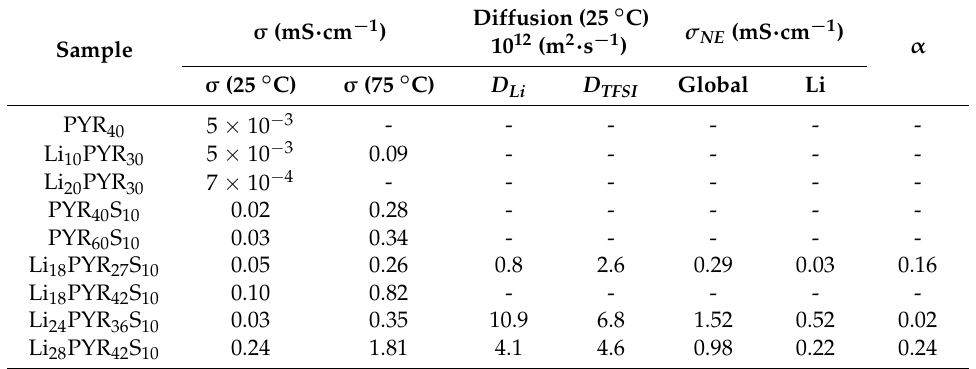
Table 3. Conductivity at 25 °C, σ (25 °C), and 75 °C, σ (75 °C), and ion diffusivity of the electrolytes. Nernst–Einstein conductivity ( σ NE ) calculated from Equation (1) and ionicity ( α ). Sample